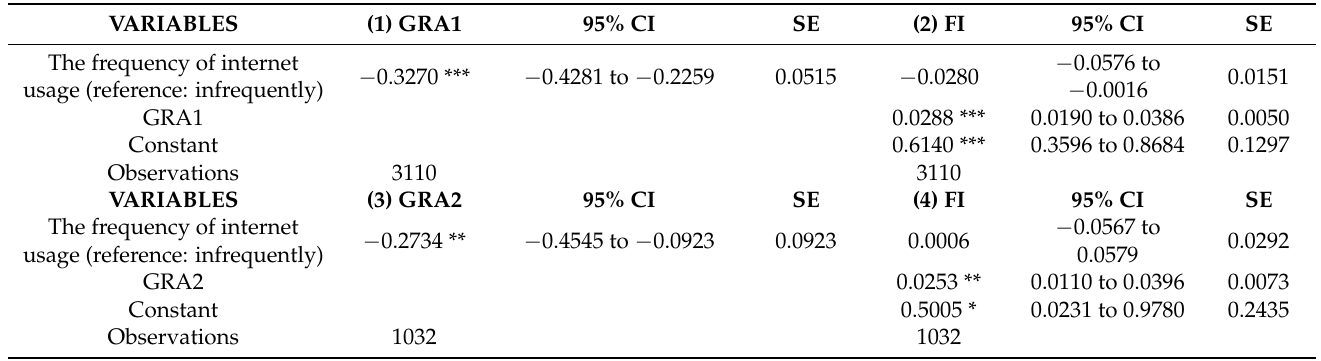
Table 4. Test of intermediary effect of internet usage frequency influencing fertility